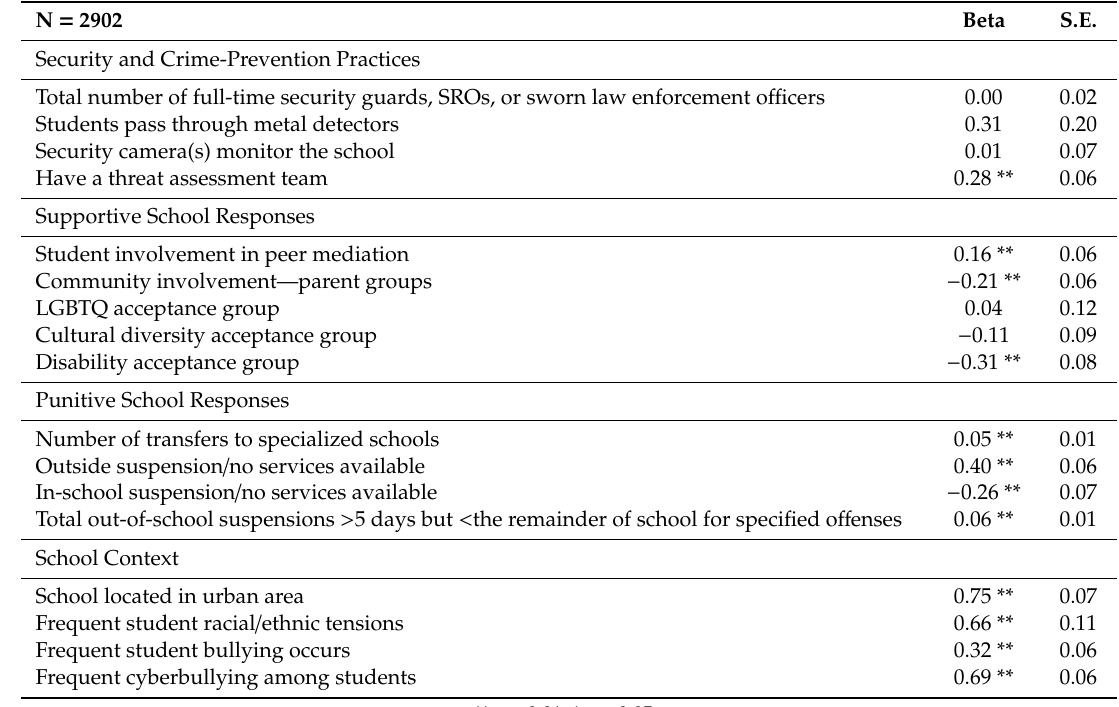
Table 4. Negative binomial regression results for disciplinary actions for attacks and fights. N = 2902